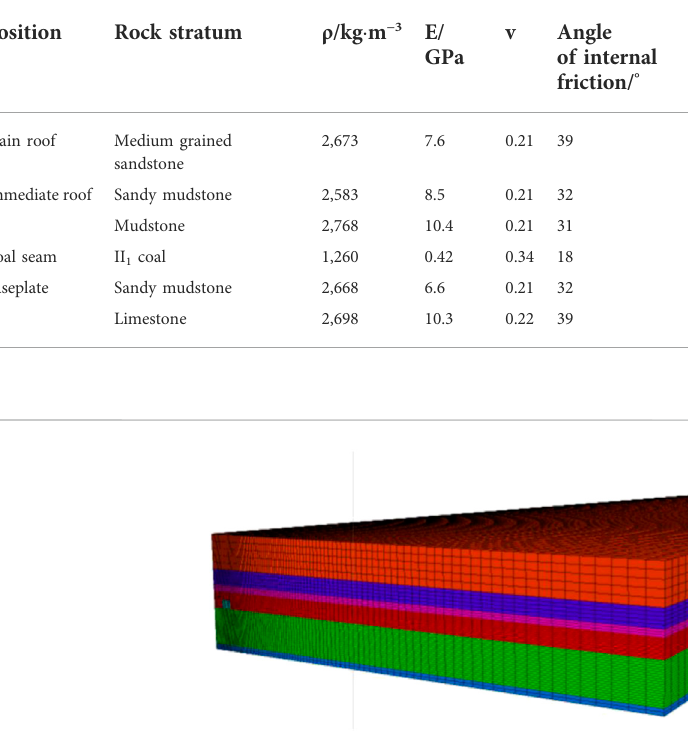
TABLE 1 Physical and mechanical parameters of coal seam roof and fl oor strata.